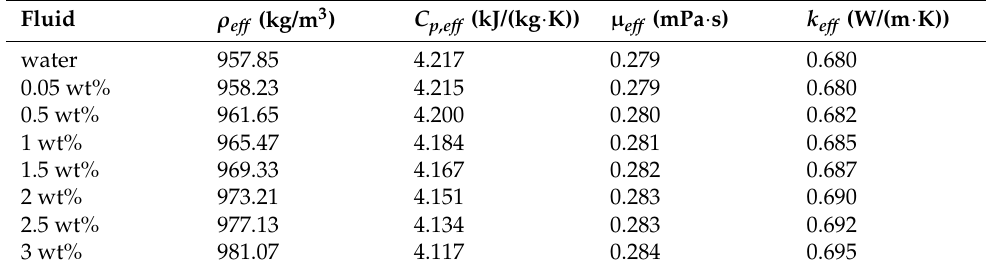
Table 1. Working fluids thermophysical properties at saturation temperature (373.15 K = 100 ◦ C) and atmospheric pressure (1.013 × 10 5 Pa).